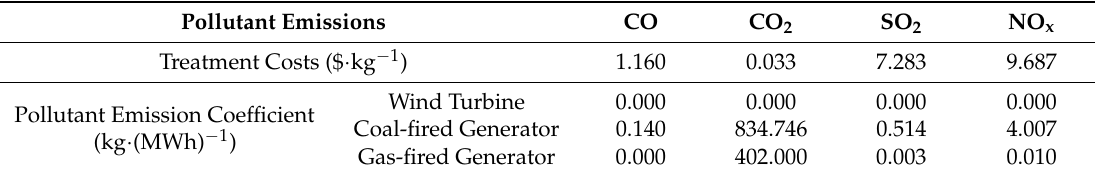
Table 5. Pollutant emission coefficients for individual generator types.